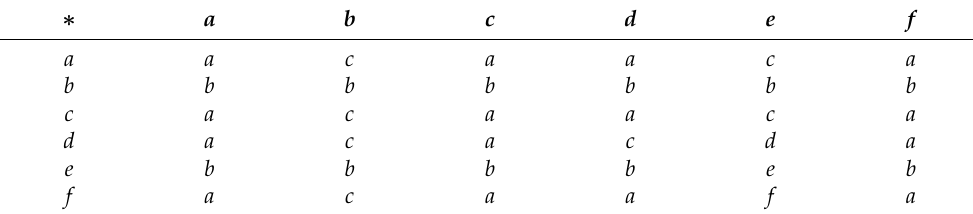
Table 7. A TA-groupoid of Example 5.